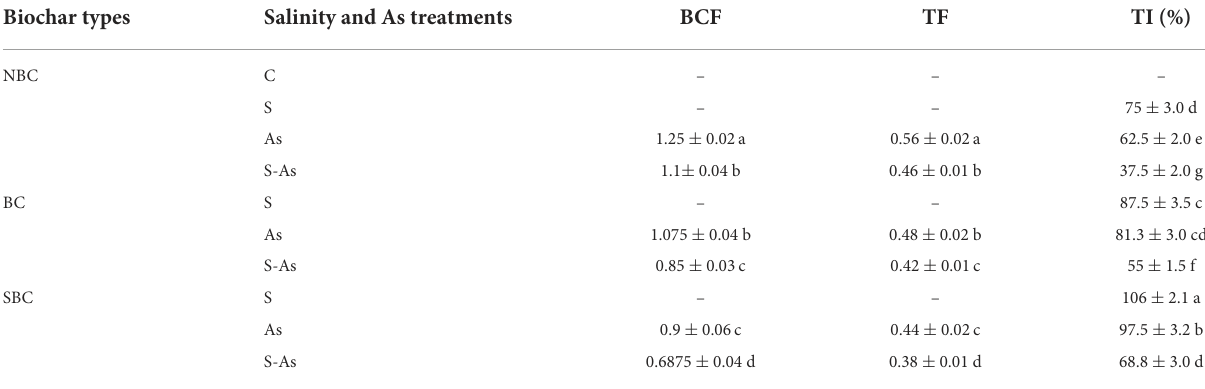
TABLE 3 Effect of salinity, arsenic, and their combination on bioconcentration factor (BCF), translocation factor (TF), and tolerance index (TI) of quinoa supplemented with no biochar (NBC), biochar (BC), and silicon-nanoparticles doped biochar (SBC). Biochar